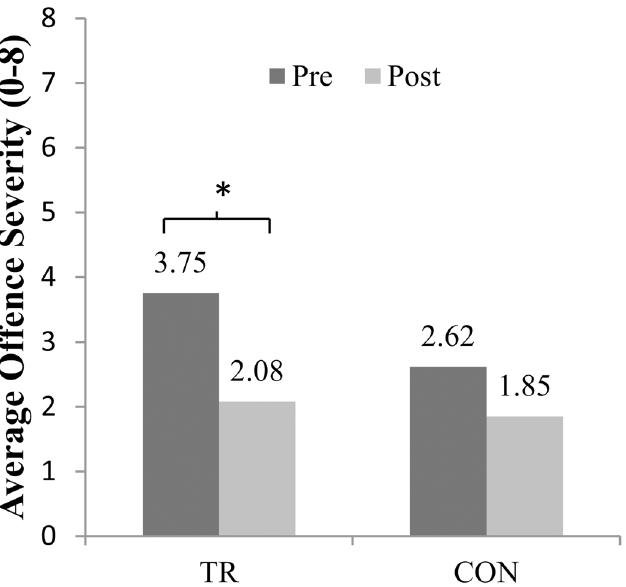
Fig 2. Effect of emotion training on crime: Offence severity 6 months before (pre) and 6 months after (post) for young offenders in the Training (TR) or Control (CON) group.